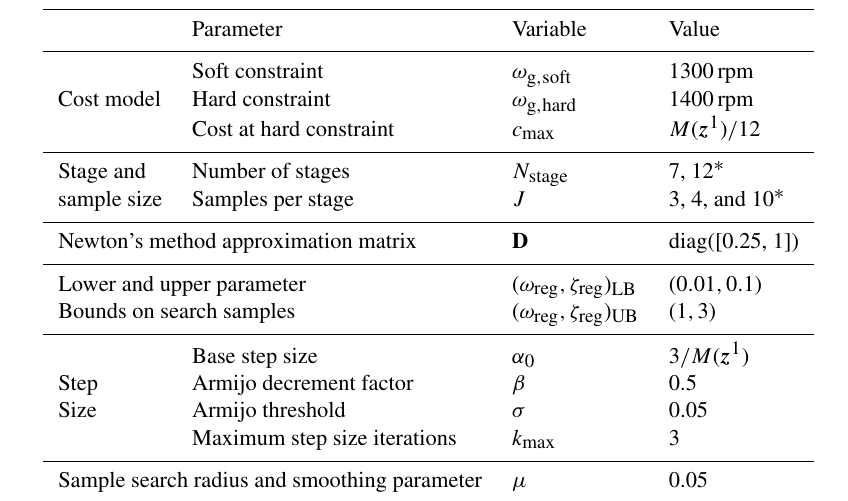
Table 2. Parameters used for the 2-D speed regulator control tuning procedure for all rotors tested. The effects of the number of stages N stage and samples per stage J on the algorithm’s performance are investigated in Section 3.2.2.